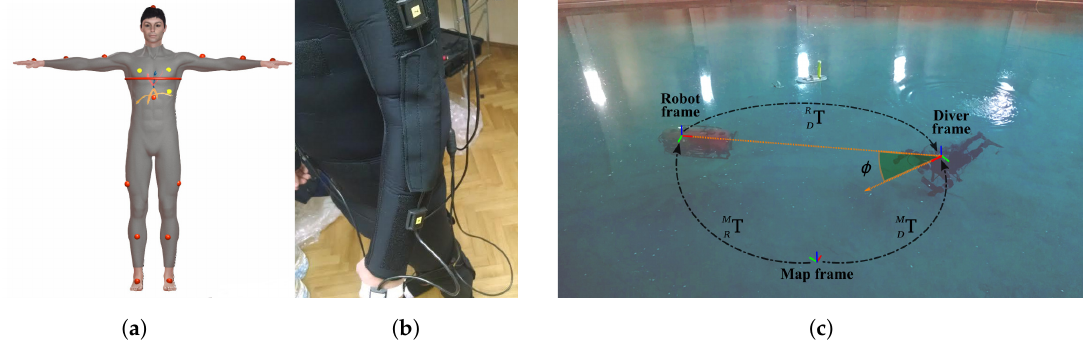
Figure 3. ( a ) position of the DiverNet 17 IMUs—red dots; ( b ) Divernet suit with sewed in sensors; ( c ) computed heading φ , filtered orientation , of the diver relative to the